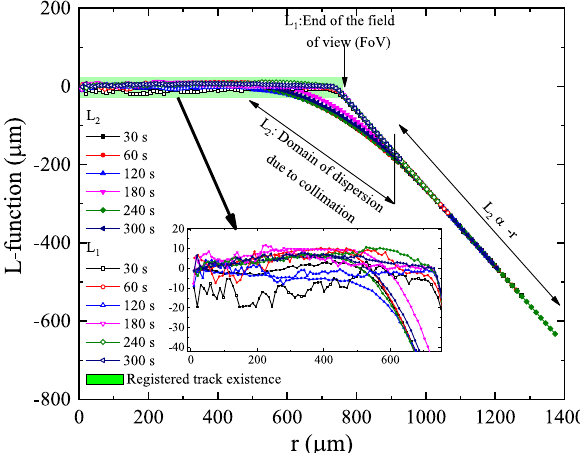
Figure 16. Plot of the L-functions L 1 ( r ) and L 2 ( r ) for samples a4, b4/1, c4, d4/1, e4, and f4.